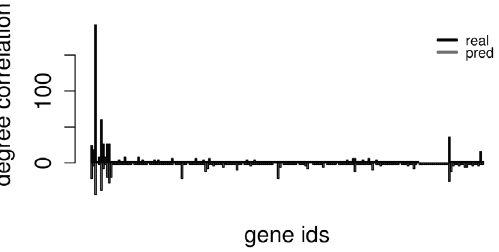
Figure 5. Degree correlation across real and predicted nodes.